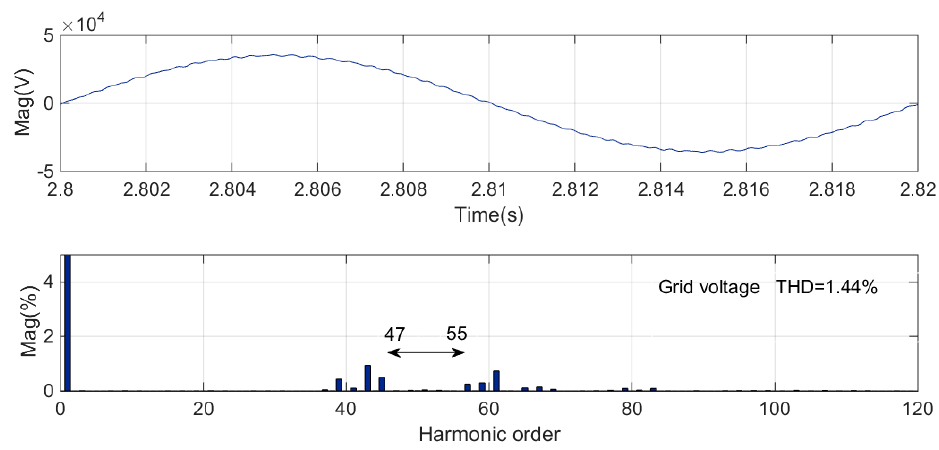
Figure 24. Waveform and FFT analysis of grid voltage with SHE-PWM algorithm.